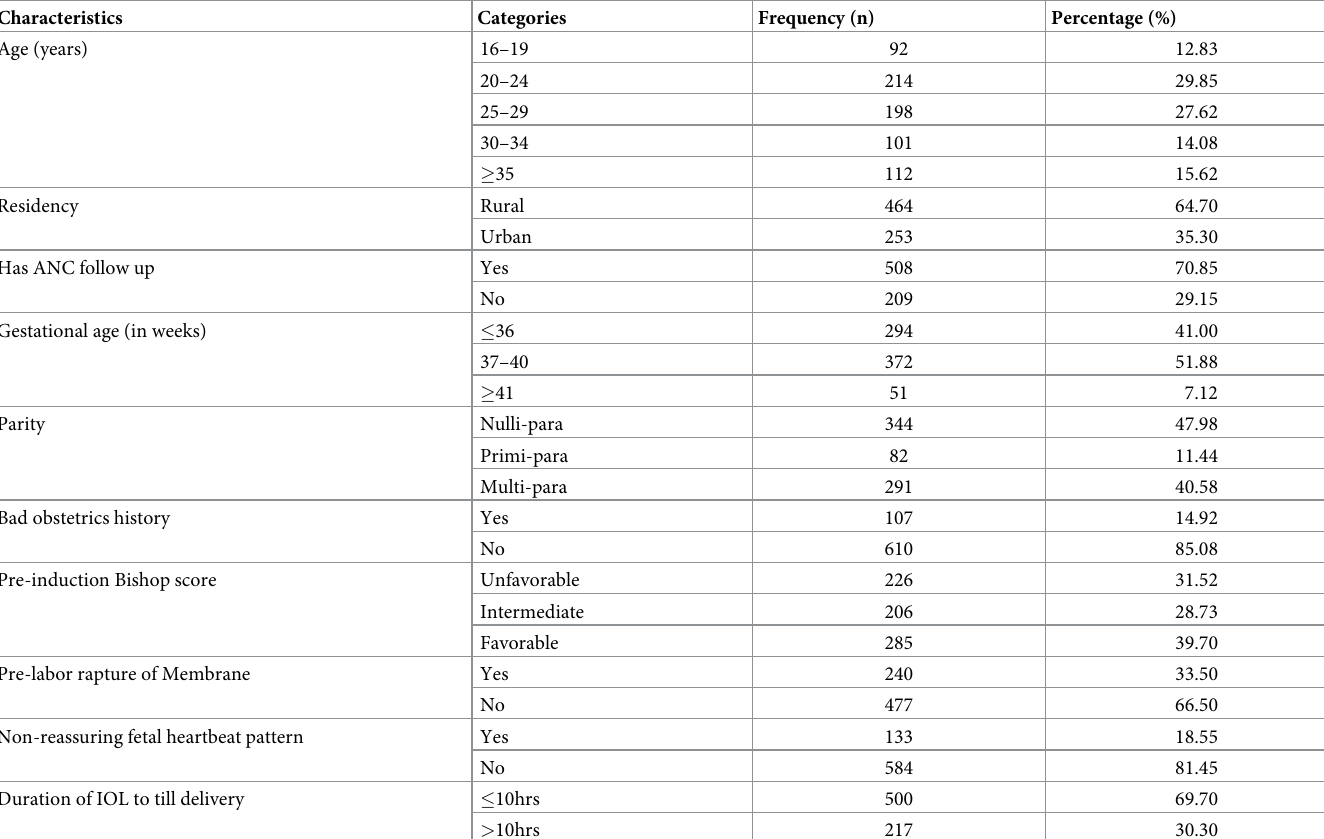
Table 1. Socio-demographic and obstetric related characteristics of mothers who delivered after induction of labor in public Hospitals of Harari Regional State, Eastern Ethiopia, 2019.